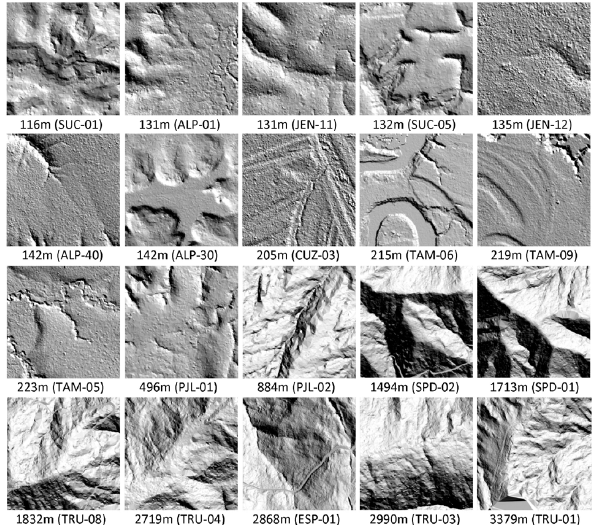
Fig. 1. Shaded relief maps showing the terrain underlying forests along an Andes-to-Amazon elevation gradient of 116m to 3379ma.s.l. Site names are shown in parentheses, matching those listed in Table 1. These results are 1.1m spatial